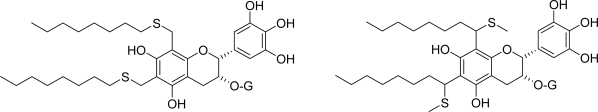
Structures of hydrophobic derivatives of EGCg [89,90].